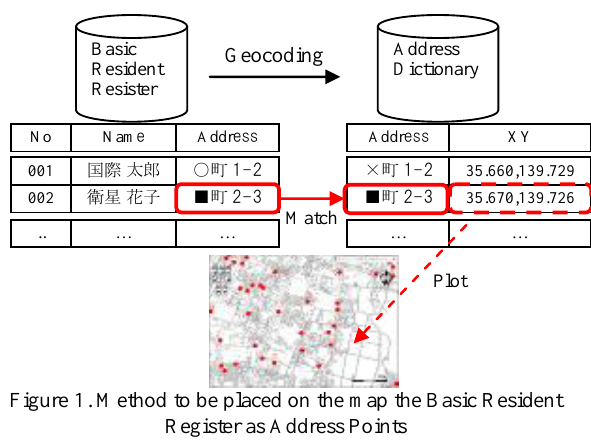
Figure 1. Method to be placed on the map the Basic Resident